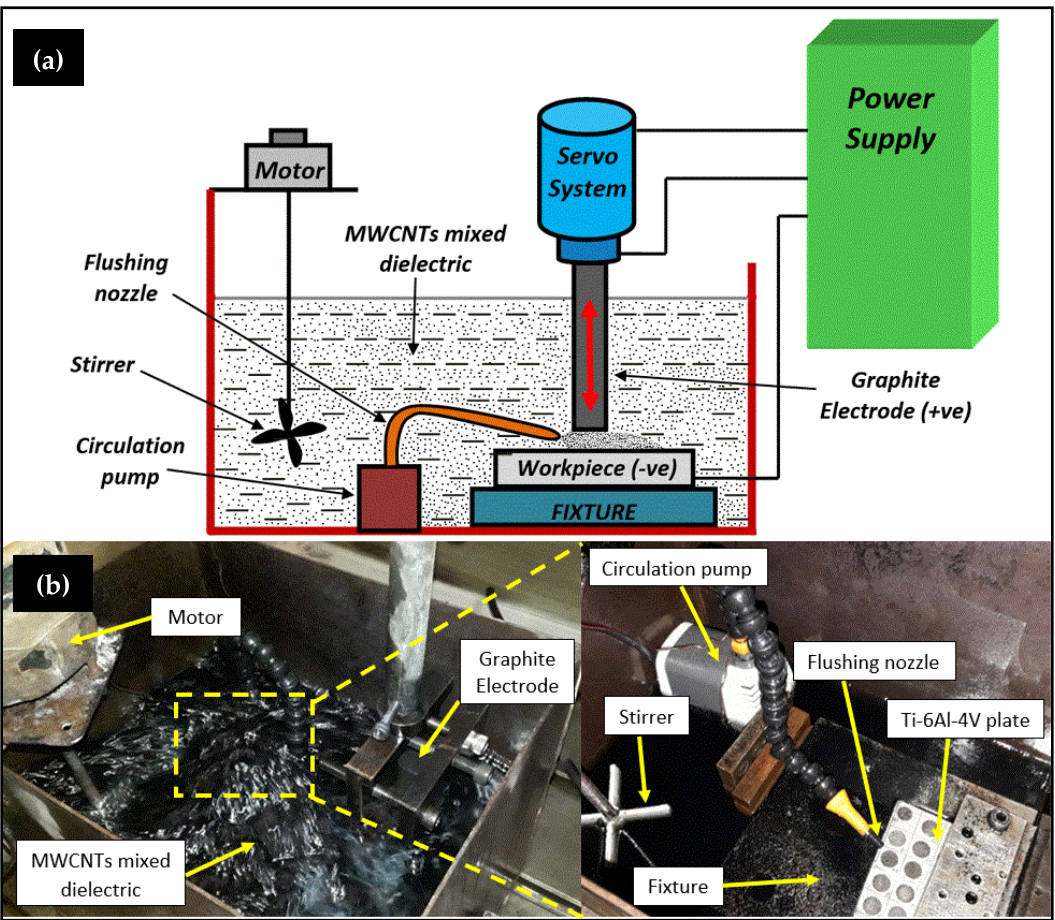
Figure 1. EDT line-diagram in; ( a ), and setup for MWCNTs-EDT in ( b ).